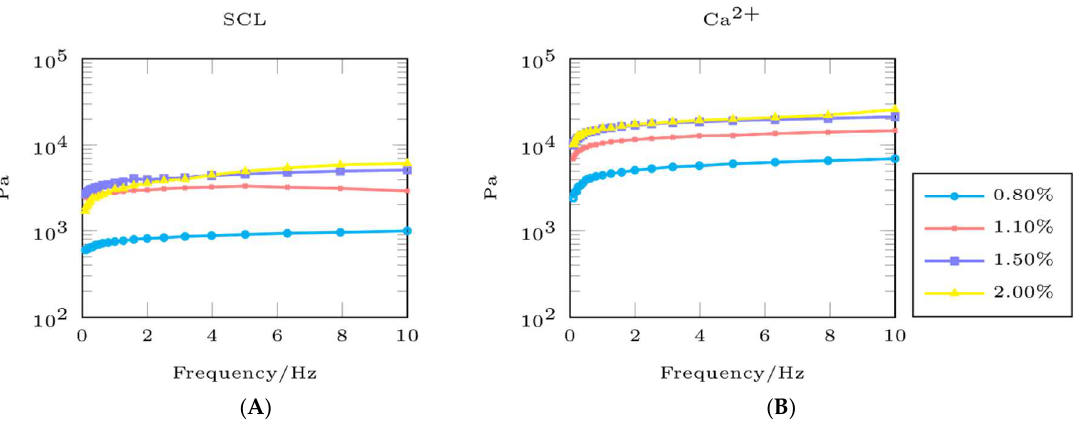
Figure 2. Rheometry data with respect to the mechanical strength of the hydrogels. 0.8%, 1.1%, 1.5%, and 2% are the concentrations of alginate in both types of hydrogels, and the varying concentrations of alginate present for the different groups of hydrogels. ( A ) The mechanical strength of SCL hydrogels with changing frequencies; ( B ) The mechanical strength of Ca 2+ hydrogels with changing frequencies